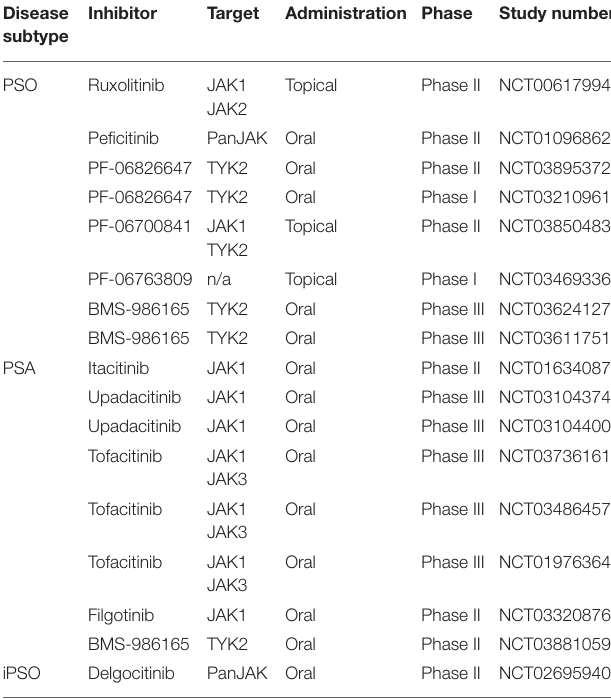
TABLE 9 | JAKi trials in psoriasis vulgaris, psoriatic arthritis and psoriasis inversa according to clinicaltrials.gov. Disease Inhibitor subtype